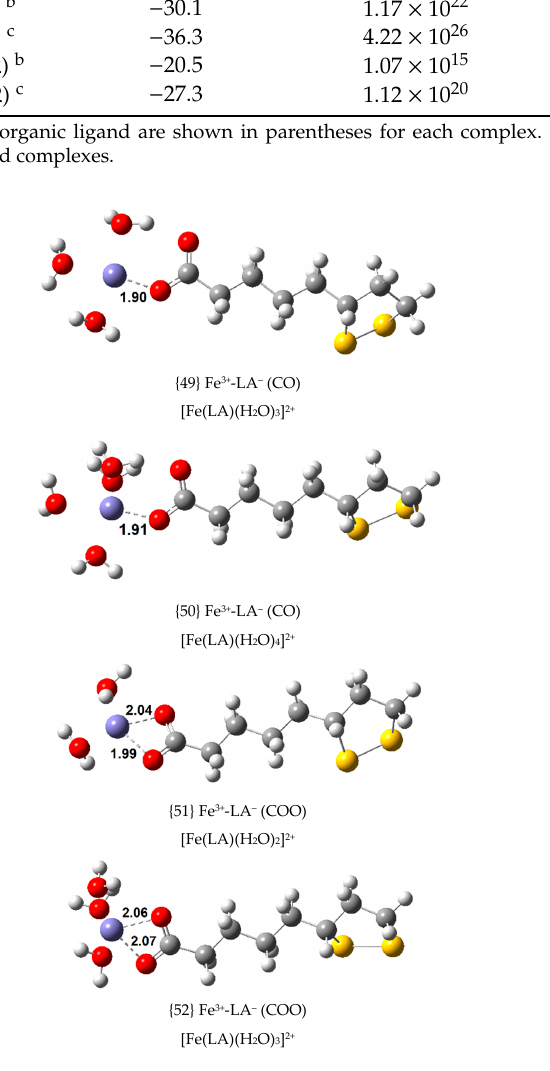
Figure 6. Optimized geometries of non-octahedral 1:1 complexes of Fe(III) with LA − (bond distances in Å).